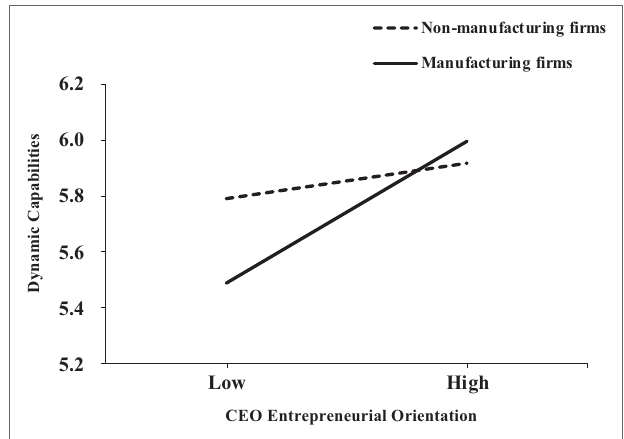
FIGURE 2 | The moderating effect of firm industry type in the relationship between CEO entrepreneurial orientation and dynamic